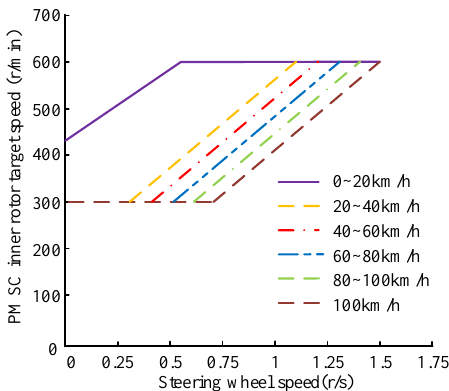
Figure 9. Calculation of PMSC inner rotor target speed.